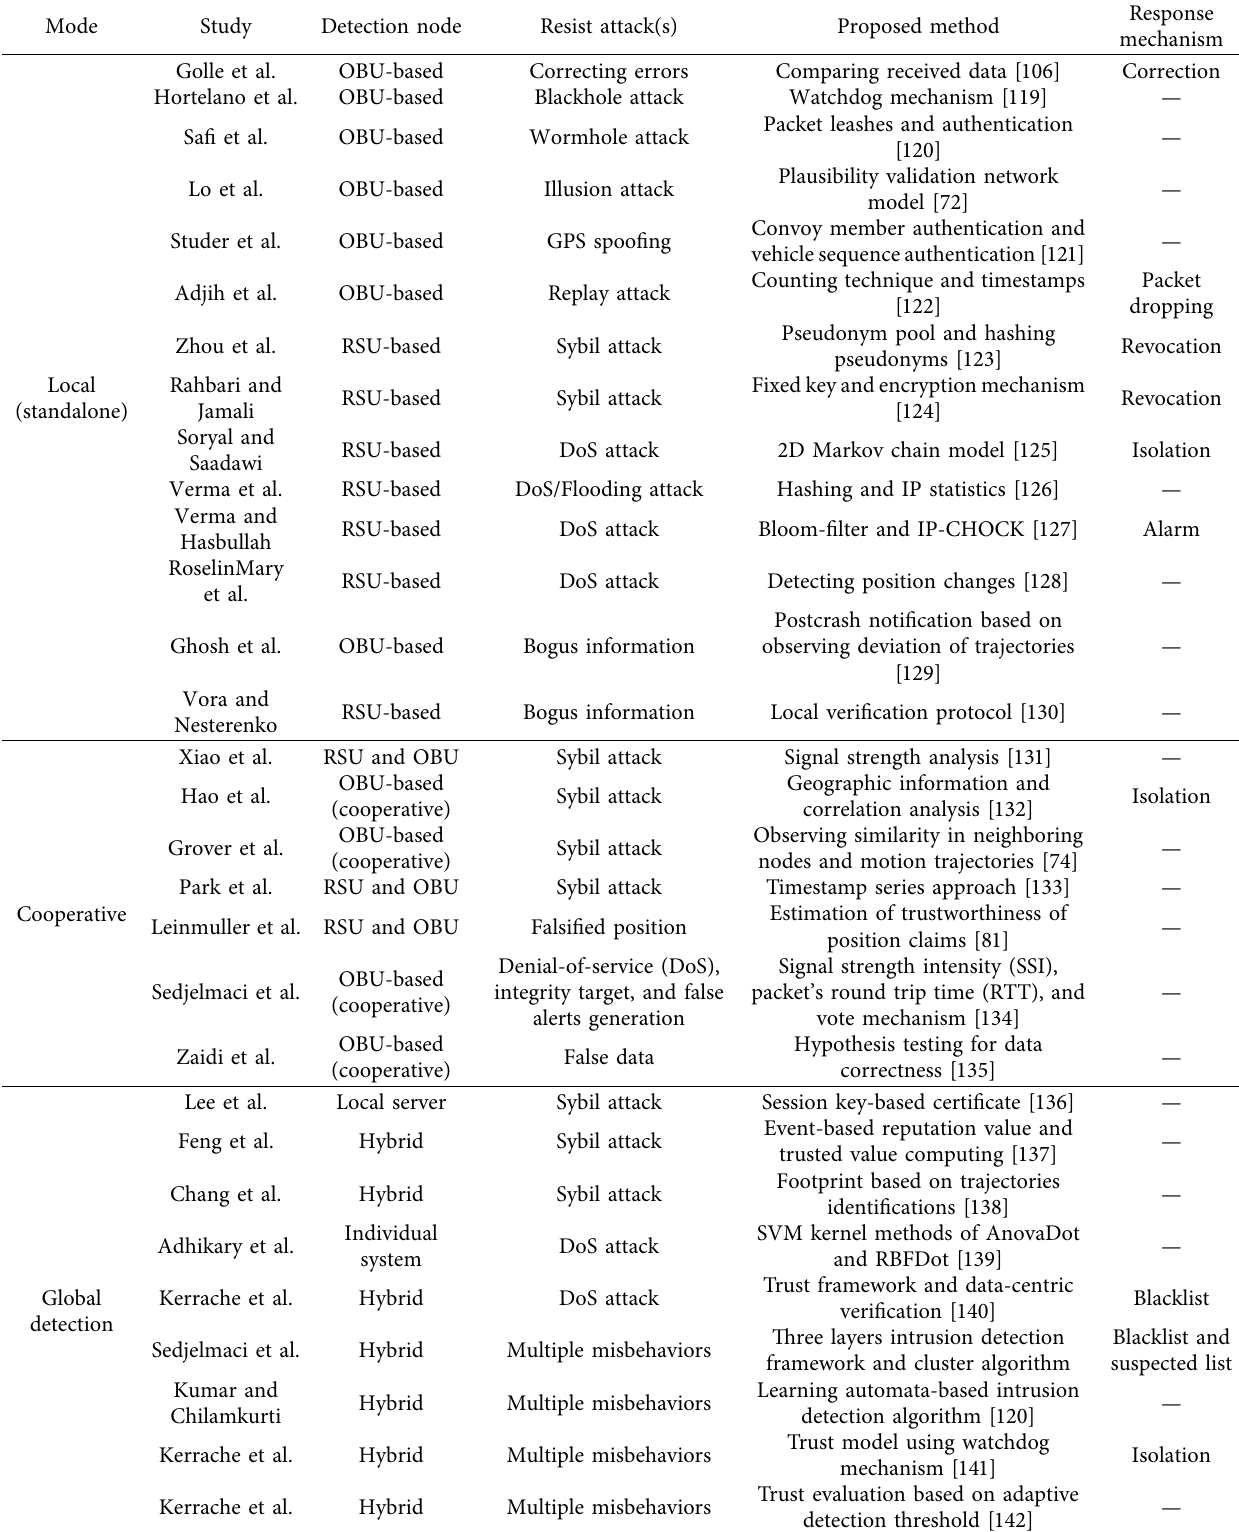
Table 3: Study of existing approaches in three